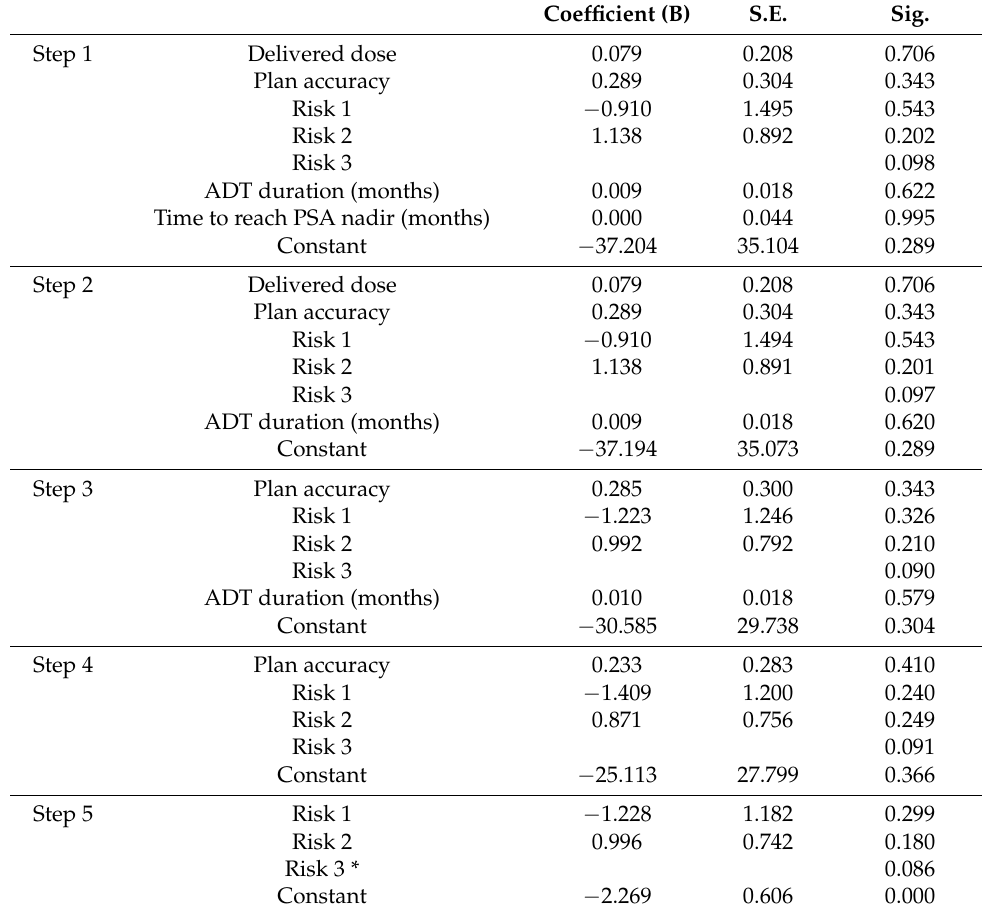
Table 2. Stepwise statistics of binary logistic regression (backward stepwise/likelihood ratio).